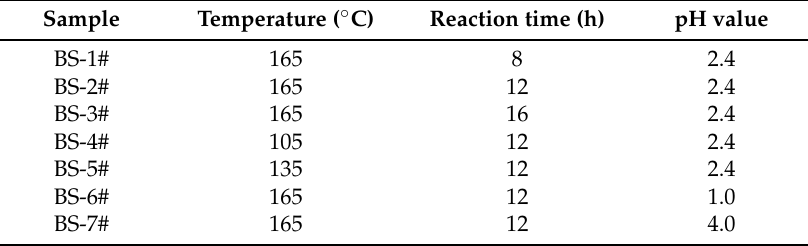
Table 1. Summary of 3D hierarchical Bi 2 S 3 architectures experimental